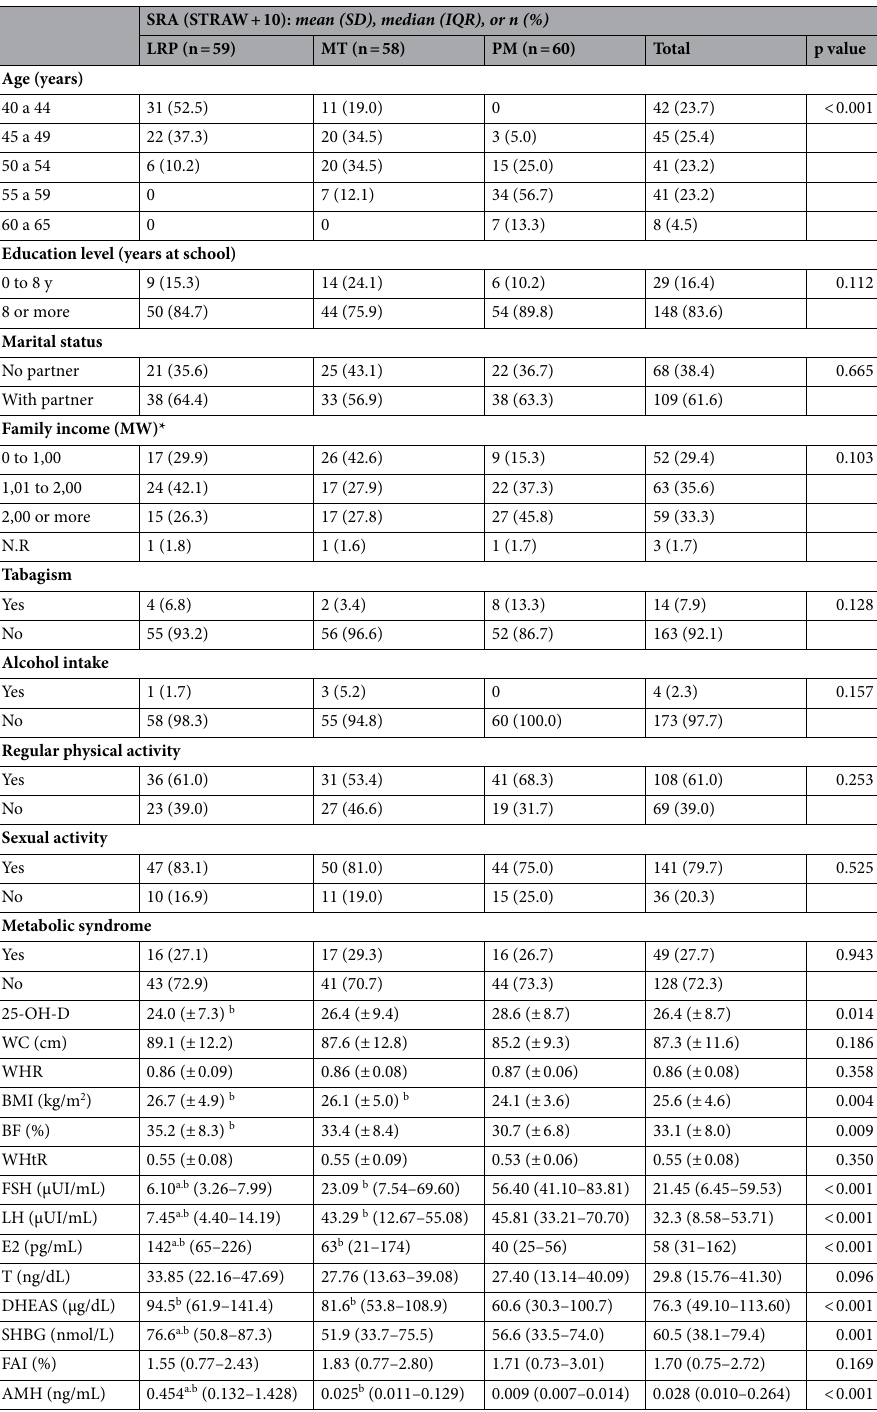
Table 1. Baseline characteristics of research subjects, according to SRA (n = 177). *The minimum wages (MW) during data collection varied from R$ 724.00 to 880.00 (2014/2016); a,b One-way ANOVA or Mann–Whitney Test; a compared to the menopausal transition (MT); b compared to the postmenopause (PM). Reference values for postmenopausal women: (FSH > 25.0 μUI/mL; LH 10.87–58.64 μUI/mL; E2 < 40 pg/mL; T < 75.0 ng/dL; DHEAS 8.0–231.0 μg/dL; SHBG 16.8–125.2 nmol/L and AMH 0.01–2.99